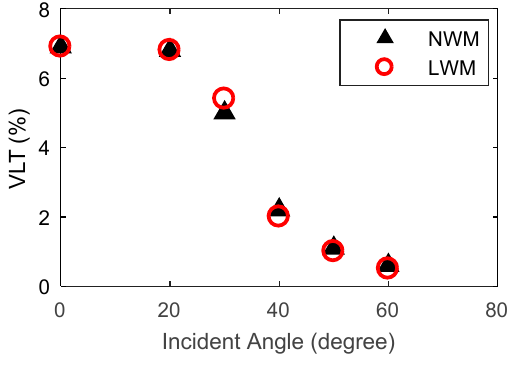
Figure 16. Experimental VLT.